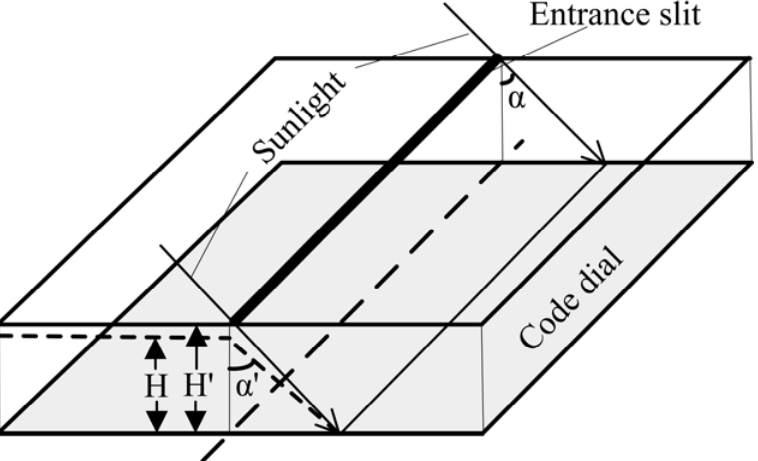
Figure 2. Deviation of distance between entrance slit and code dial.